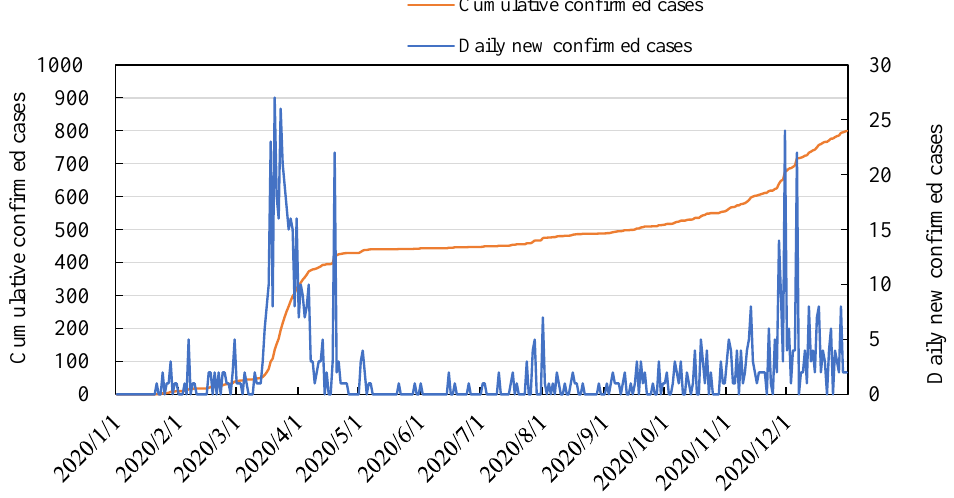
Figure 1. COVID-19 confirmed cases in Taiwan in 2020.